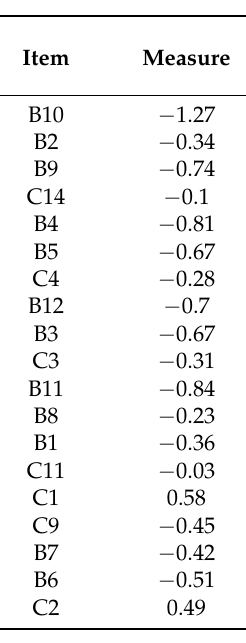
Table 3. Item polarity and item